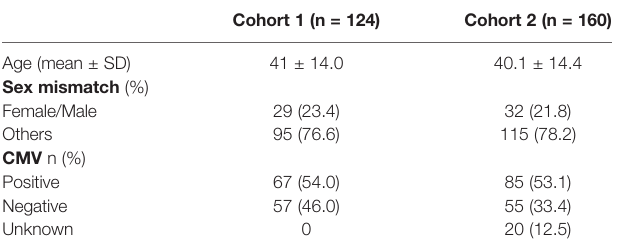
TABLE 2 | HSC donor characteristics.